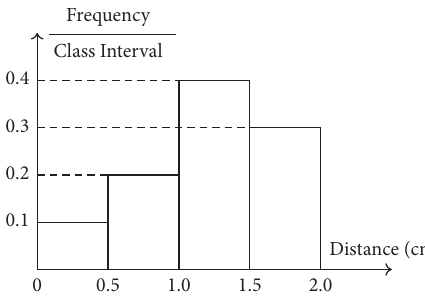
Figure 7: Example of frequency